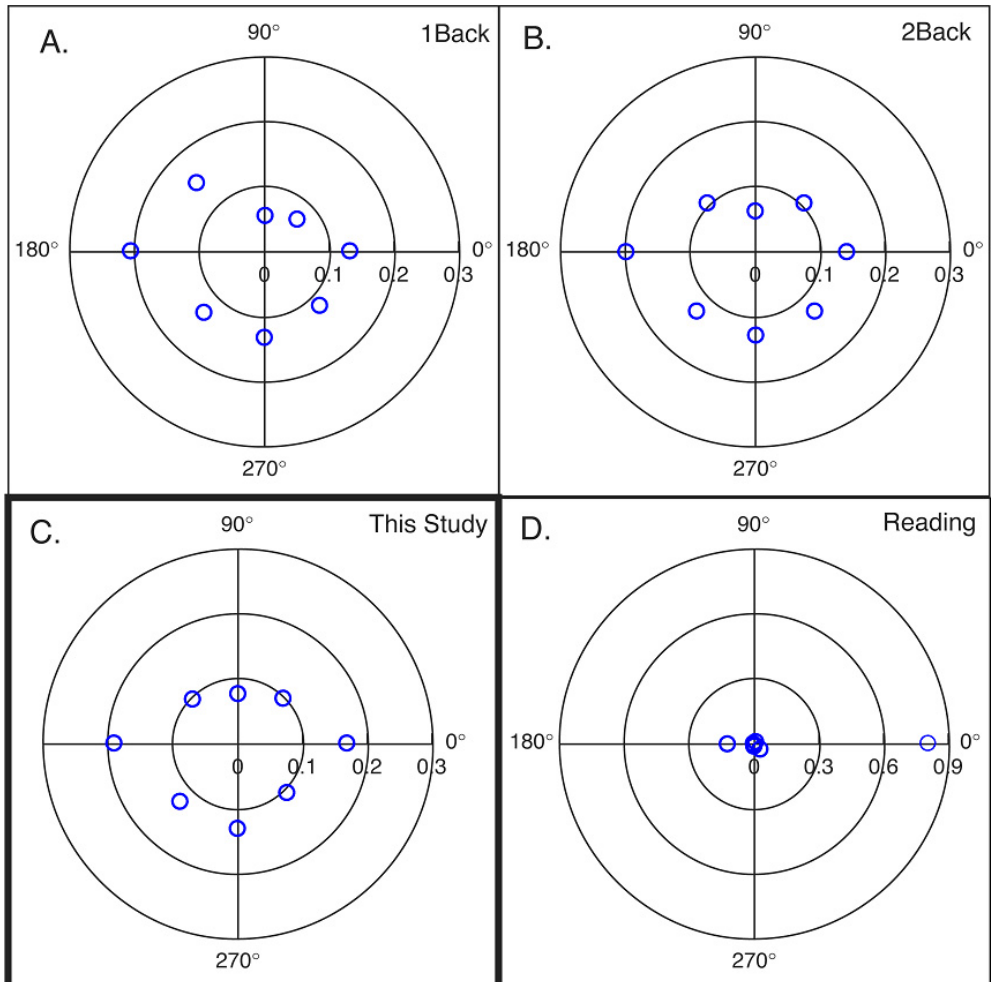
FIGURE 5 . Percentage of saccades executed in various absolute directions. (a) search pattern from Klein and MacInnes ([1], Experiment 1); (b) search pattern from Klein & MacInnes ([1], Experiment 2); (c) search pattern from the current study; (d) search during reading (from [20]). Note the scale difference in